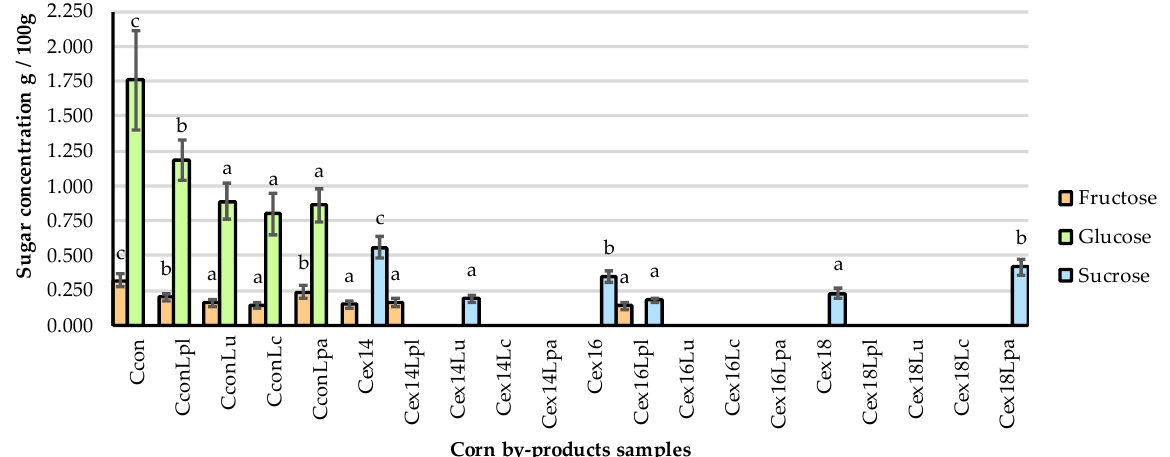
Figure 3. The sugars mass concentration in corn by-products. C—corn by-product samples; con—control samples (non-extruded, non-fermented); Lpl, Lu, Lc, Lpa—fermented with L. plantarum - LUHS122, L. uvarum -LUHS245, L. casei -LUHS210, and L. paracasei -LUHS244 strains, respectively; ex—extruded samples; 14, 16, 18—moisture content of the corn by-product samples. Data are rep- resented as means ( n = 3) ± SE. a–c—mean values denoted with different letters are significantly different between samples ( p ≤ 0.05).